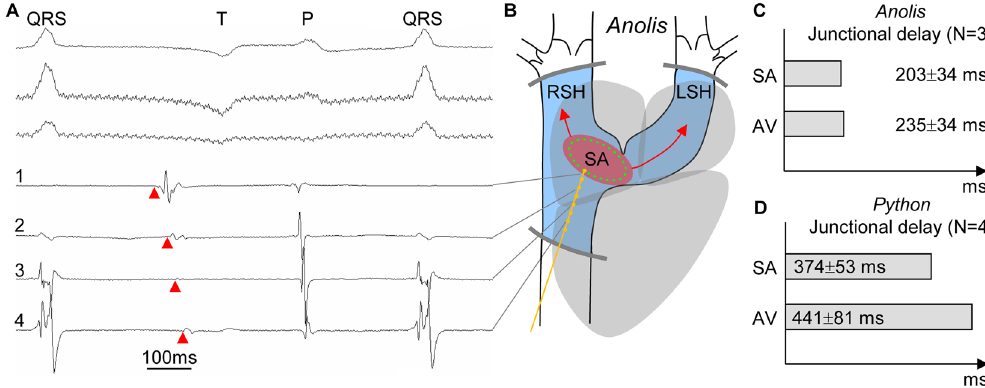
Figure 3. The sinuatrial junctional area harbors the dominant pacemaker, has a delay, and the sinus venosus is activated retrograde in both Anolis and Python . ( A ) Original traces of three-lead surface ECG (upper part of the panel) and local recordings from 4 bi-polar electrodes in Anolis equestrie (traces 1 to 4 in lower part of the panel). Electrode 1 is in the sinuatrial junctional area, whereas electrode 4 is the furthest into the posterior sinus horn. Deflections in all 4 electrodes can be seen to align with the P- and QRS-waves of the ECGs and these deflections are considered remote activity. The deflections indicated by red arrowheads occur prior to the deflections aligned with the P-wave and are therefore considered local electrograms of the sinus venosus. The earliest deflection is in electrode 1 and the latest in electrode 4, thereby showing dominant pacemaker activity in the sinuatrial junctional area and retrograde activation of the posterior sinus horn. In electrode 1, the interval between the early deflection (red arrowhead) and the deflection aligned with the P-wave constitutes the substantial sinu-atrial delay. ( B ) All sinus horns are activated retrograde from the sinu-atrial junctional area and the activation front stops at the pericardial reflection. ( C , D ) Within species, the sinu-atrial (SA) and atrioventricular (AV) delays are of similar duration. LSH, left sinus horn; RSH, right sinus